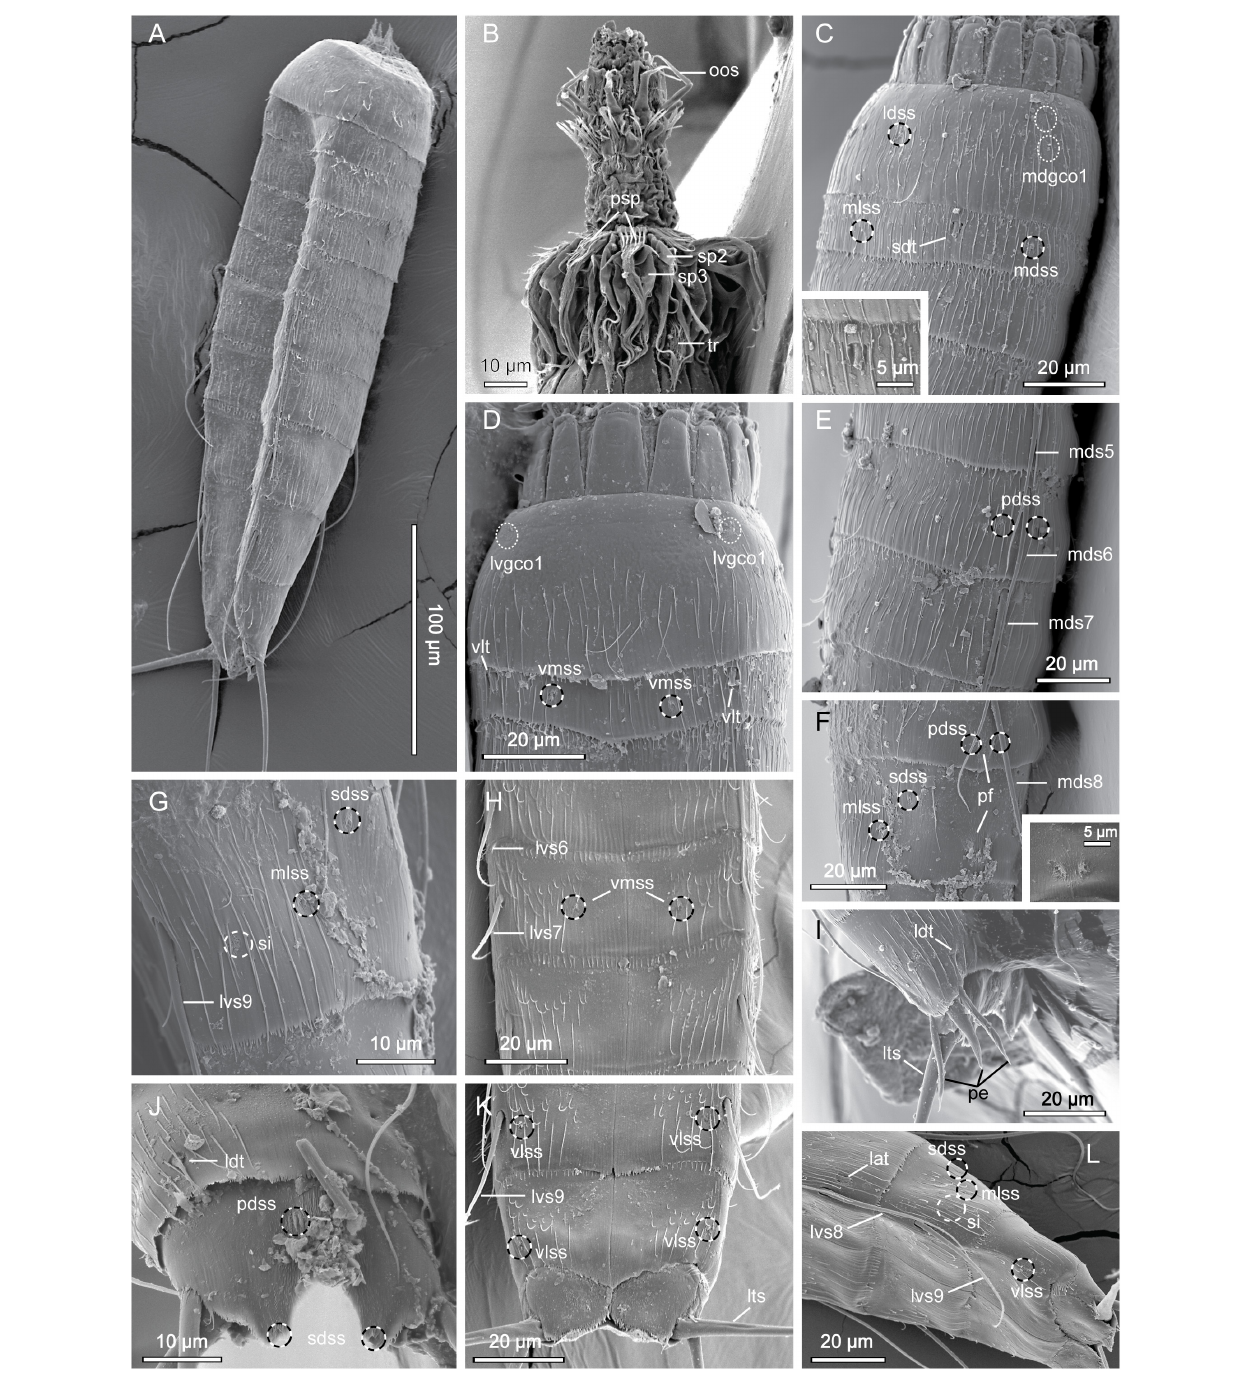
FIGURE 4 | Scanning electron micrographs showing overviews and details of Echinoderes mamaqucha sp. nov. (A) Lateroventral overview. (B) Mouth cone and introvert sectors 8 to 7. (C) Segments 1 to 3, dorsolateral view, with close-up showing subdorsal tube on segment 2. (D) Segments 1 to 2, ventral view. (E) Segments 5 to 7, dorsolateral view. (F) Segments 8 to 9, dorsolateral view, with close-up showing papillary flap on segment 9. (G) Segment 9, lateral view. (H) Segments 6 to 8, ventral view. (I) Segments 10 to 11 of male, lateral view. (J) Segments 10 to 11 of female, dorsal view. (K) Segments 9 to 11 of female, ventral view. (L) Segments 8 to 11, lateroventral view. lat , lateral accessory tube; ldss , laterodorsal sensory spot; ldt , laterodorsal tube; lts , lateral terminal spine; lvgco1 , lateroventral glandular cell outlet type 1; lvs , lateroventral spine, followed by segment number; mdgco1 , middorsal glandular cell outlet type 1; mds , middorsal spine, followed by segment number; mdss , middorsal sensory spot; mlss , midlateral sensory spot; oos , outer oral style; pdss , paradorsal sensory spot; pe , penile spine; pf , papillary flap; psp , primary spinoscalid; sdss , subdorsal sensory spot; sdt , subdorsal tube; si , sieve plate; sp , spinoscalid followed by introvert ring number; tr , trichoscalid; vlss , ventrolateral sensory spot; vlt , ventrolateral tube; vmss , ventromedial sensory spot.